Question: What form of chart is displayed?
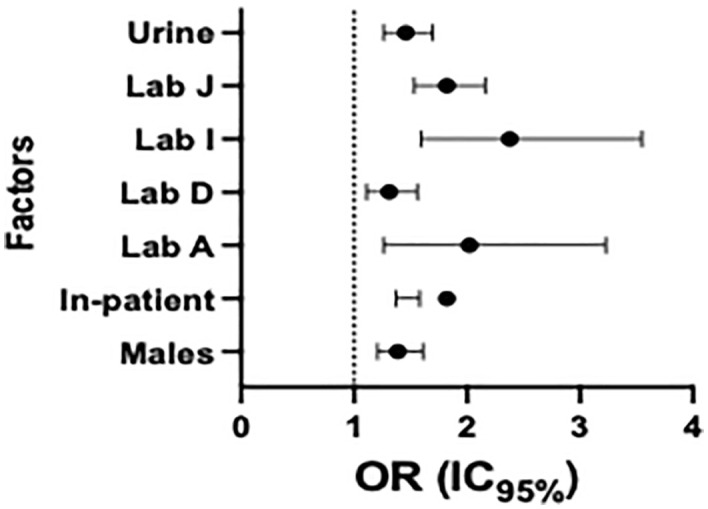
Answer: forest